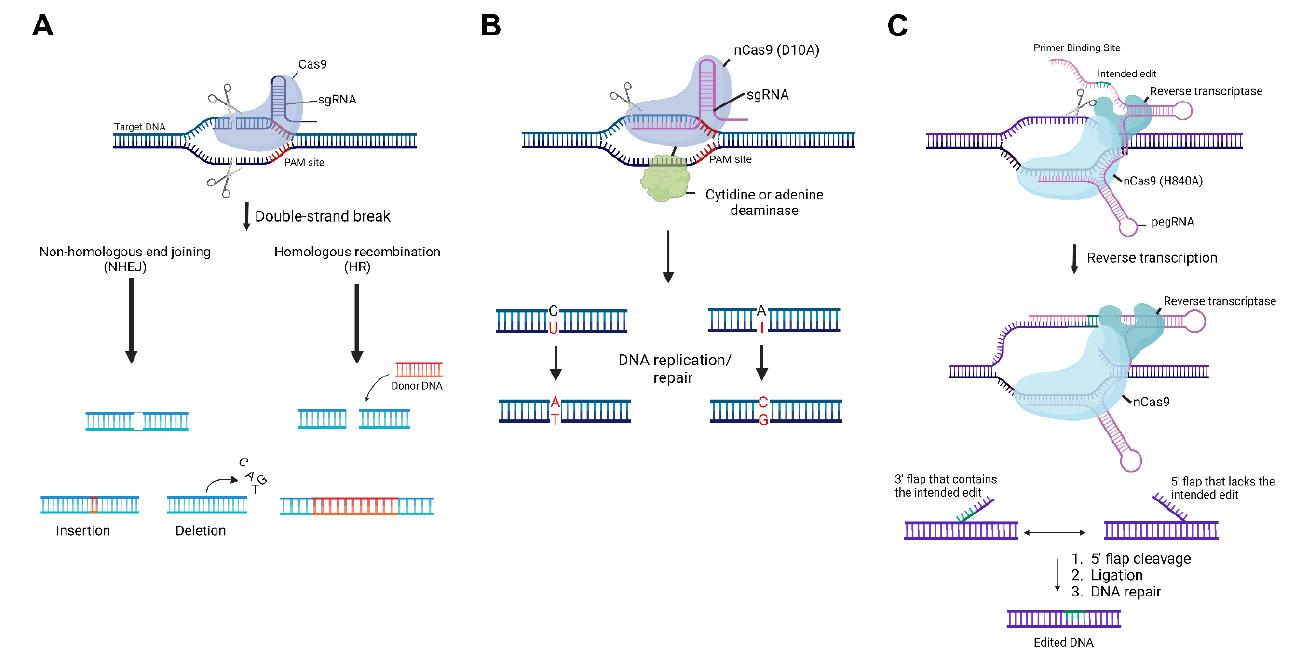
Figure 1. Overview of the clustered regularly interspaced short palindromic repeats (CRISPR) toolbox. ( A ) Illustration of the original CRISPR/CRISPR-associated protein 9 (Cas9) System. Upon recognition of the target sequence, Cas9 will cleave both strands of deoxyribonucleic acid (DNA). This will result in two natural DNA repair pathways — non-homologous end joining and homologous recombination, which will lead to a small insertion or deletion, or a large insertion containing a donor DNA template, respectively. ( B ) Illustration of the base editing system. A Cas9 nickase (nCas9) is fused to a cytidine or adenine deaminase and upon nicking the single strand of DNA, the enzyme will deaminate the cytosine or adenine, leading to a uracil or inosine, respectively. Then, DNA replication or repair will recognize the change and lead to a permanent base pair conversion. ( C ) Illustration of the prime editing system. Prime editing utilizes a Cas9 nickase fused to a reverse transcriptase and a prime editing guide ribonucleic acid (pegRNA) that contains the spacer sequence, primer binding site, and the template containing the intended edit. After recognition and the single-strand nick, the primer binding site will allow for the exposed 3 ′ -hydroxyl end of the nicked DNA strand to initiate the reverse transcription of the template. This results in an intermediate that includes two DNA flaps: a 3 ′ flap that contains the desired edit, and a 5 ′ flap that contains the unedited strand. After equilibration between the two flaps, cleavage, ligation, and DNA repair, the stably edited DNA sequence remains. PAM, protospacer adjacent motif; sgRNA, single guide ribonucleic acid.